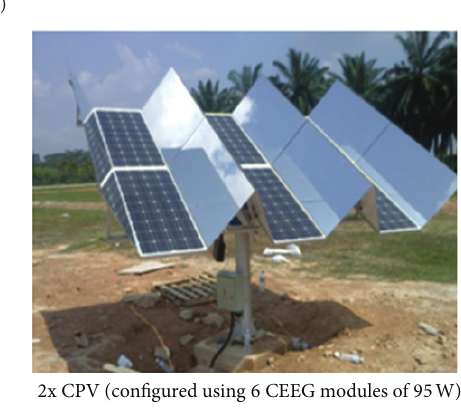
Figure 1: Overview of 3 types of PV generators installed at